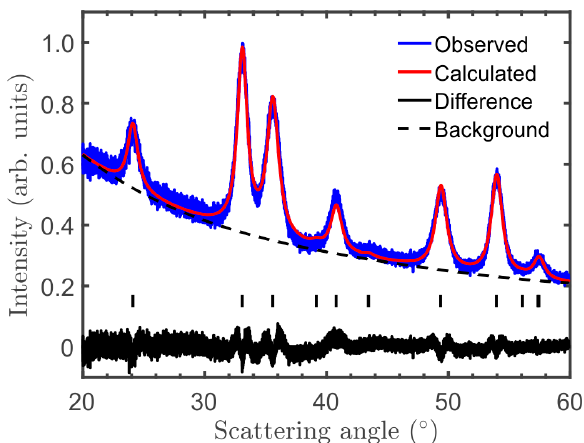
Figure 2. XRD pattern of the as-prepared sample. The tick marks correspond to the (cid:1844)3(cid:3364)(cid:1855) structure of